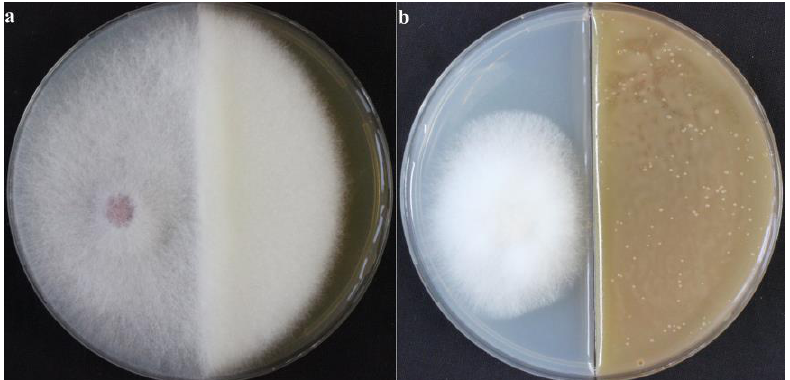
Figure 4. Inhibitory effect of volatile organic compounds produced by Xenorhabdus bovienii on NK-NH1. The plates were incubated at 28 °C for 5 days, n = 3. ( a ) NK-NH1 was inoculated on the left half of the plate and culture medium was applied on the right half; ( b ) NK-NH1 was inoculated on the left half of the plate and X. bovienii was inoculated on the right half.